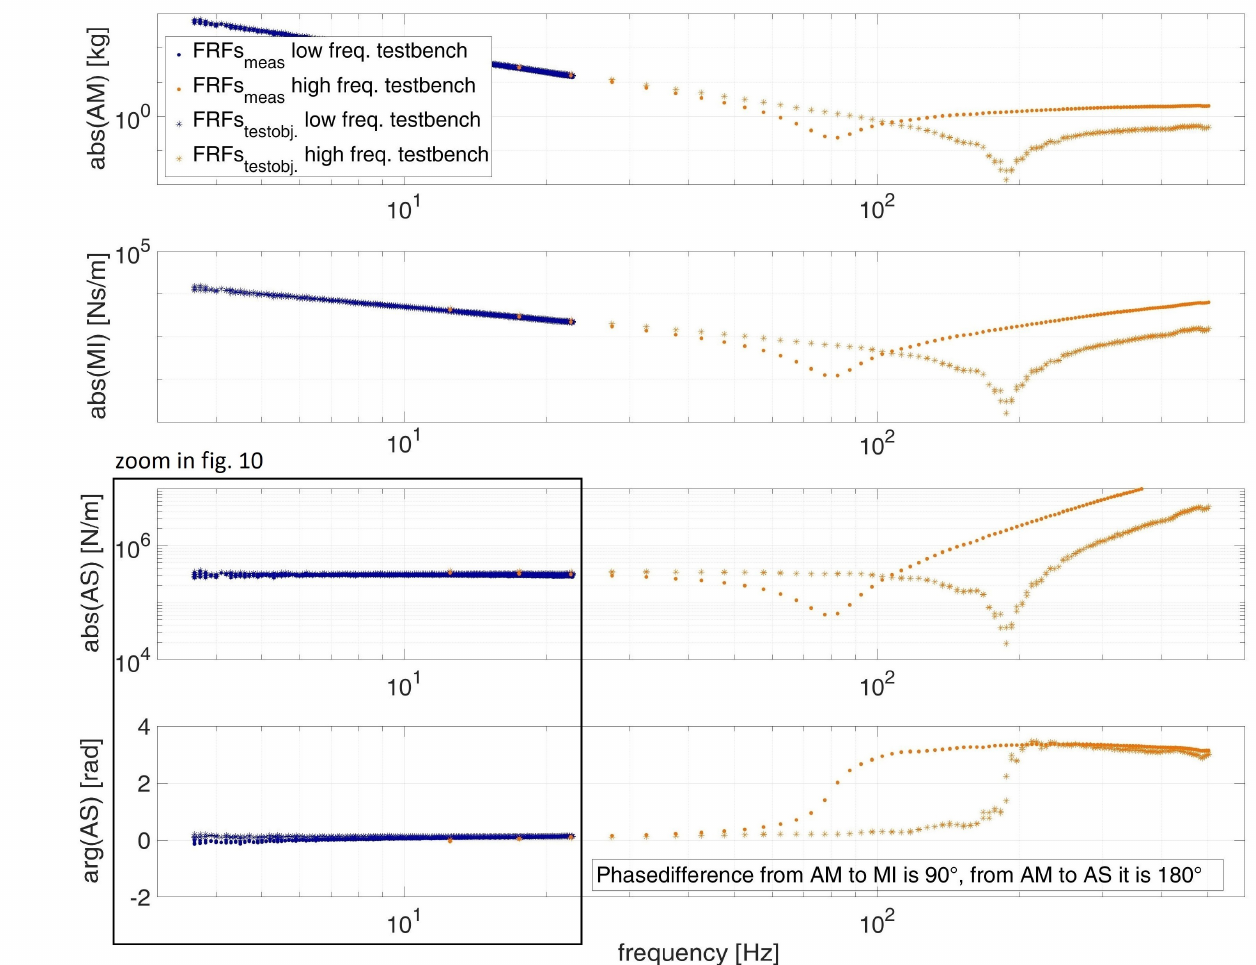
Figure 9. FRFs AM, MI, AS and its phase directly measured and the calibrated FRFs of the compliant element A over